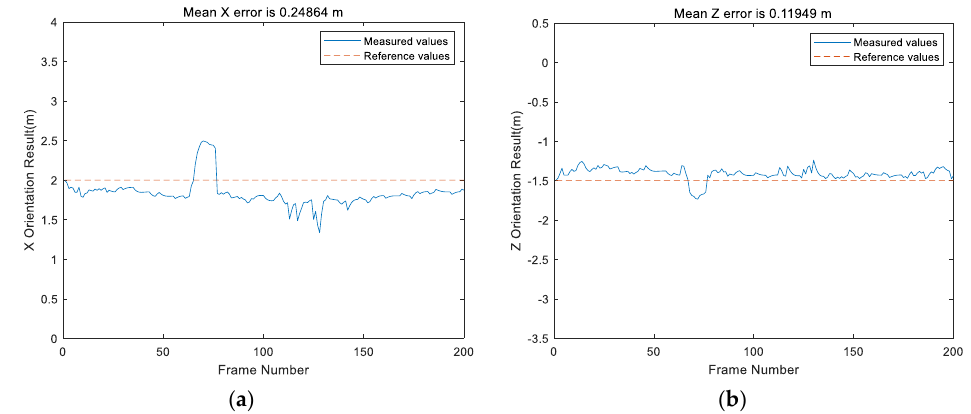
Figure 13. The STKF positioning results under the source rotation for the point (2, −1.5). ( a ) Error in the x–direction. ( b ) Error in the z–direction.